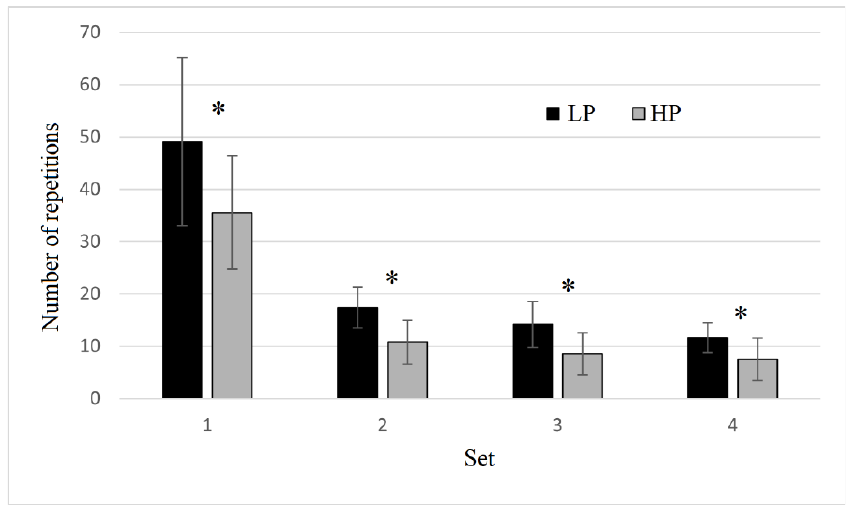
Figure 1. Number of repetitions to failure performed in the four sets provided in both high pressure (HP) and low pressure (LP) trials. * indicates a significant ( p ≤ 0.05) difference between HP and LP. The pattern of muscle oxygenation during each trail can be observed in Figure 2. A significant trial x time interaction was detected for RestO 2 (F = 19.750; p < 0.001; η 2 =